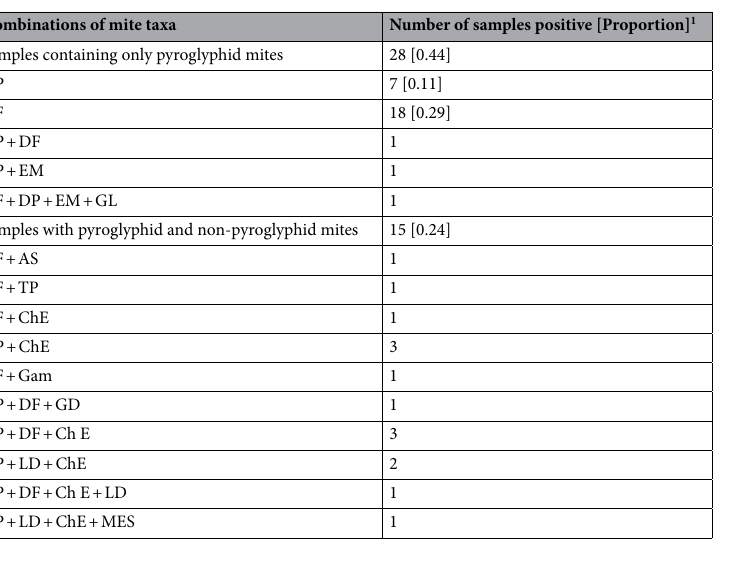
Table 2. Combinations of the occurrence of particular pyroglyphid and non-pyroglyphid mite taxa and their relative frequency in the examined dwellings of asthmatic patients in Bytom (south Poland). 1 in relation to a total of samples examined (n = 63) (all proportions can be calculated by the reader, only those > 0.1 are shown), DF: Dermatophagoides farinae, DP: Dermatophagoides pteronyssinus, EM: Euroglyphus maynei, GL: Gymnoglyphus longior, AS: Acarus siro complex, TP: Tyrophagus putrescentiae, GD: Glycyphagus domesticus, LD: Lepidoglyphus destructor , ChE: Cheyletus eruditus, MES: Mesostigmata.